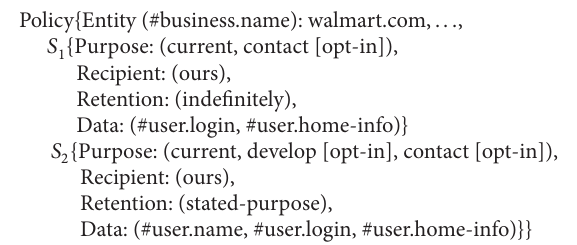
Algorithm 1: The P3P policy structure and an example P3P policy from http://www.walmart.com/ (the structure of P3P privacy pol- icy). Algorithm 2: The P3P policy structure and an example P3P